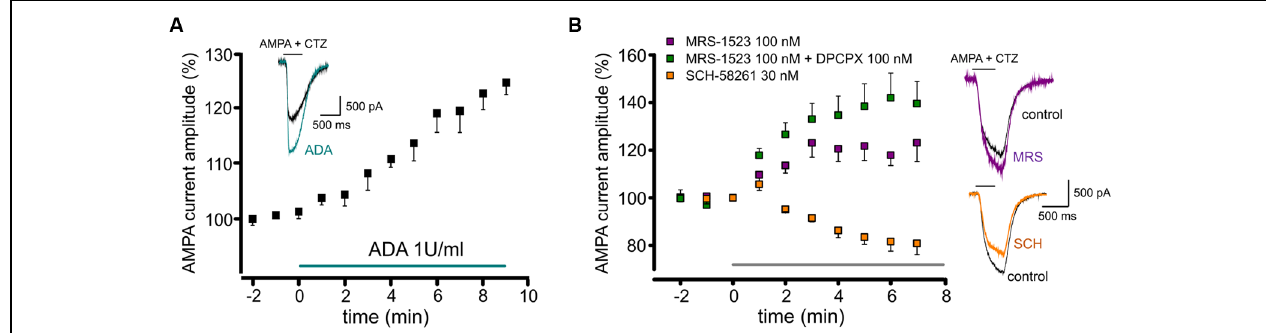
FIGURE 1 | Tonic activation of adenosine receptors modulates AMPA currents in mouse hippocampal neurons. (A) time course and sample traces of AMPA current (AMPA 10 μ M, CTZ 25 μ M) potentiation induced by acute treatment with Adenosine deaminase (ADA, 1 U/ml, n = 5; p < 0.05) in cultured hippocampal neurons. (B) Left, time course of AMPA current modulation by acute treatment with adenosine receptors antagonists blocking specifically: A 3 R (MRS1523, 100 nM, n = 5, purple), A 3 R + A 1 R (MRS1523 + DPCPX, n = 5, green) or A 2A R (SCH58261 30 nM, n = 5, orange). Application of all drugs starts at t = 0, gray bar. Right, sample traces of AMPA currents in control (black) and in the presence of MRS1523 (purple) or SCH58261 (orange).